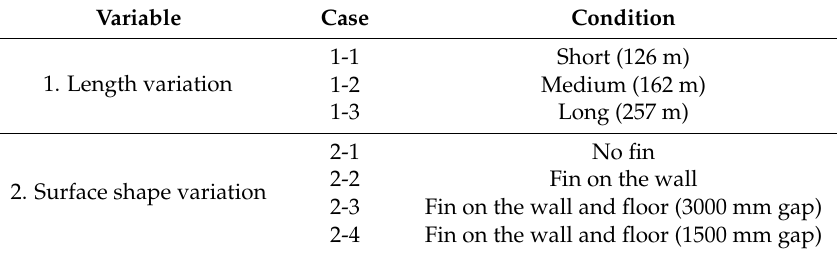
Table 2. Cases set considered for the